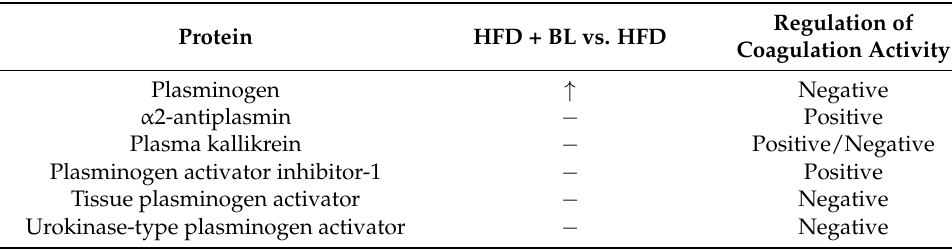
Table 2. Effect of bromelain on the expression of proteins involved in the fibrinolytic system in HFD − fed mice.